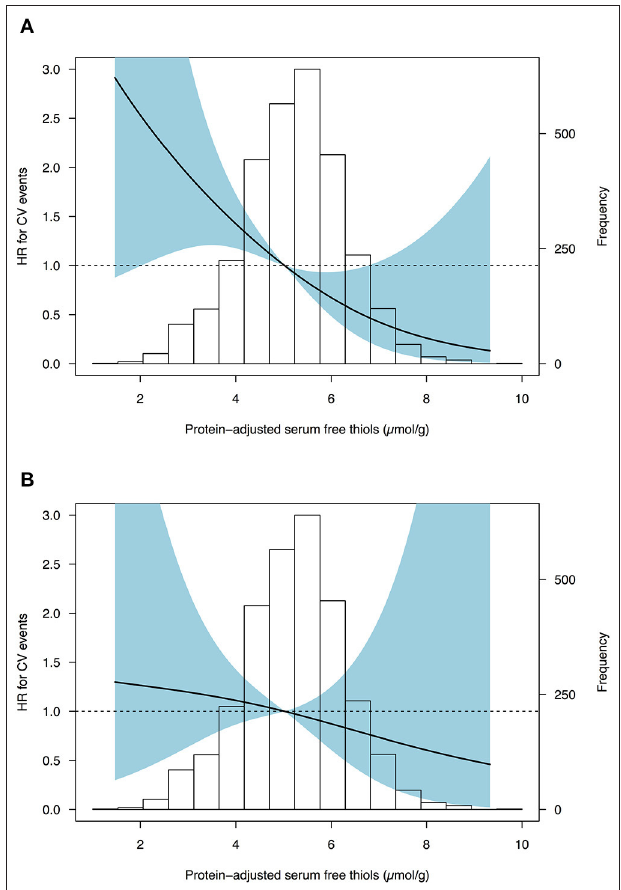
FIGURE 4 | Restricted cubic splines (RCS) showing no deviance from linear associations of serum free thiols with the risk of CV events in females from the general population. (A) Cox proportional hazards regression analysis of serum free thiols with estimated associations with the risk of cardiovascular events based on restricted cubic splines with three knots ( Model 1 ). (B) Cox proportional hazards regression analysis of serum free thiols with estimated associations derived from the fully adjusted model ( Model 4 ). Median of serum free thiols was taken as reference standard (5.02 µ mol/g). Likelihood ratio test for non-linearity was not statistically significant ( χ 2 = 0.14; P = 0.708). Light-blue shaded areas represent 95% confidence